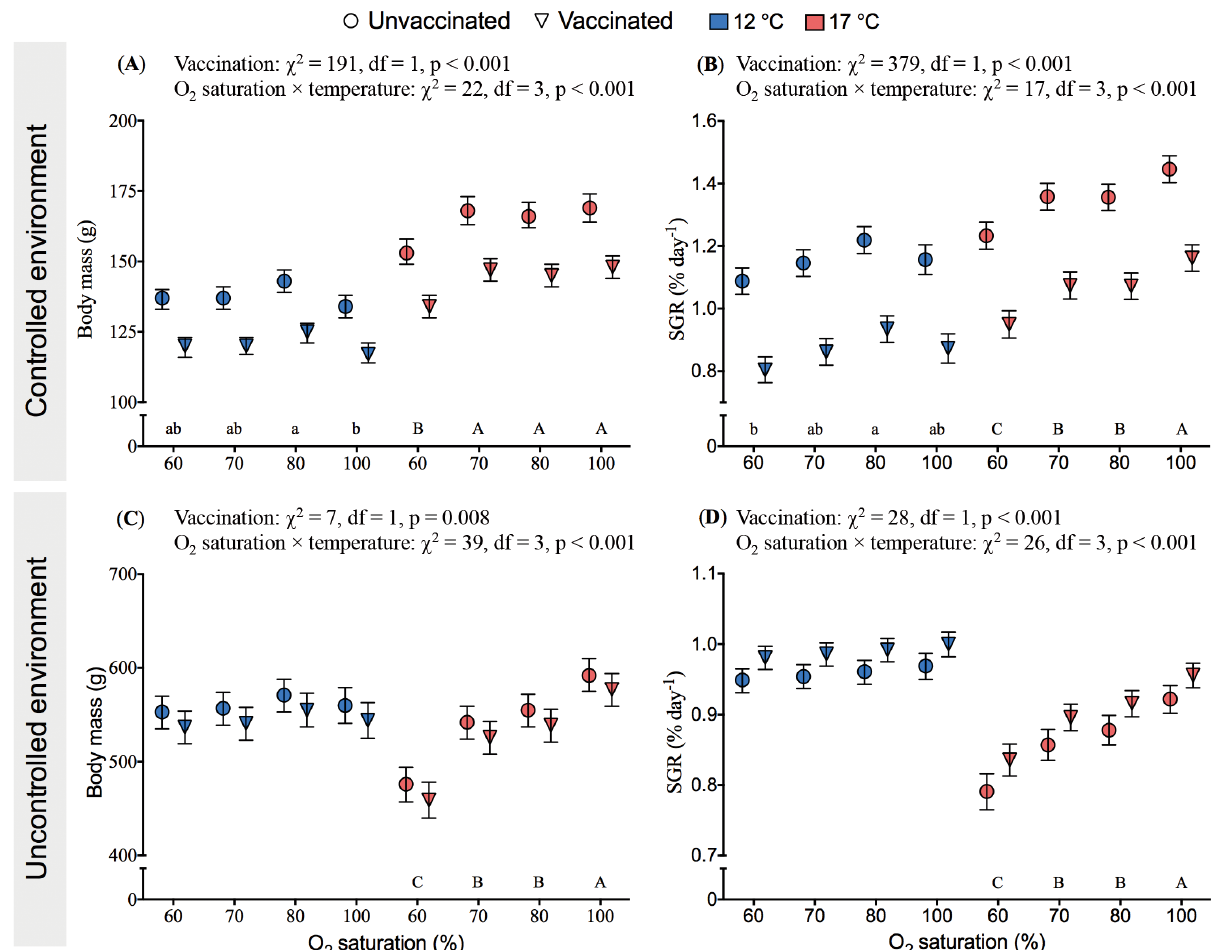
Fig. 2. Body mass and growth data over time for vaccinated and unvaccinated Atlantic salmon reared under different con- trolled conditions of temperature and oxygen (O 2 ) saturation between 10 October and 30 November 2016 before common- garden rearing in uncontrolled environmental conditions within a sea-cage. (A) Body mass on 30 November 2016, (B) specific growth rate (SGR) between 10 October and 30 November 2016, (C) body mass on 26 April 2017, and (D) SGR between 30 No- vember 2016 and 26 April 2017. Data are means ± 95% CI (n = 67−89 group −1 time −1 ). The results from linear mixed effect mod- els are presented for each time point. Different lowercase letters indicate significant O 2 saturation effects at 12°C whereas uppercase letters indicate significant O 2 saturation effects at 17°C (post hoc, least square means, p < 0.05)